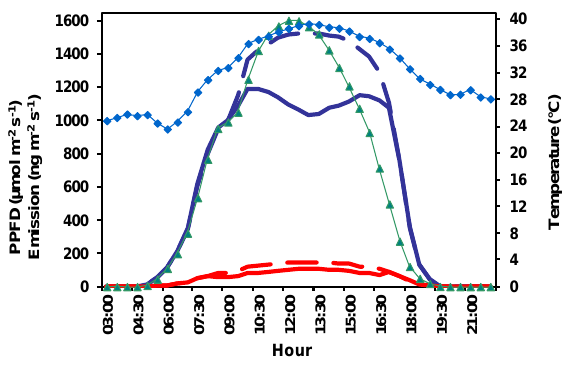
Fig. 4. Simulated MT-hc (purple) and SV (red) emissions from light (green) and temperature (blue) data recorded during a hot summer day over a Mediterranean oak forest in Southern France. Simula- tions were made by assuming either constant light and temperature responses of emissions (dashed lines) or variable responses (straight lines) using the parameters deduced from data sets given in Fig. 3 (see text for more